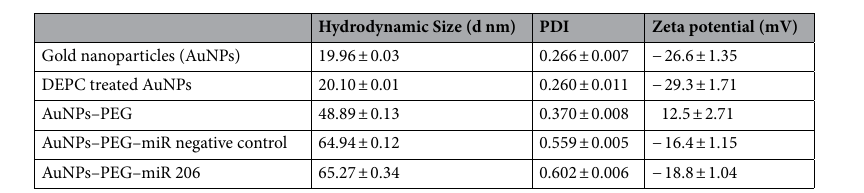
Table 1. Hydrodynamic size and zeta potential of different nano-formulation using dynamic light